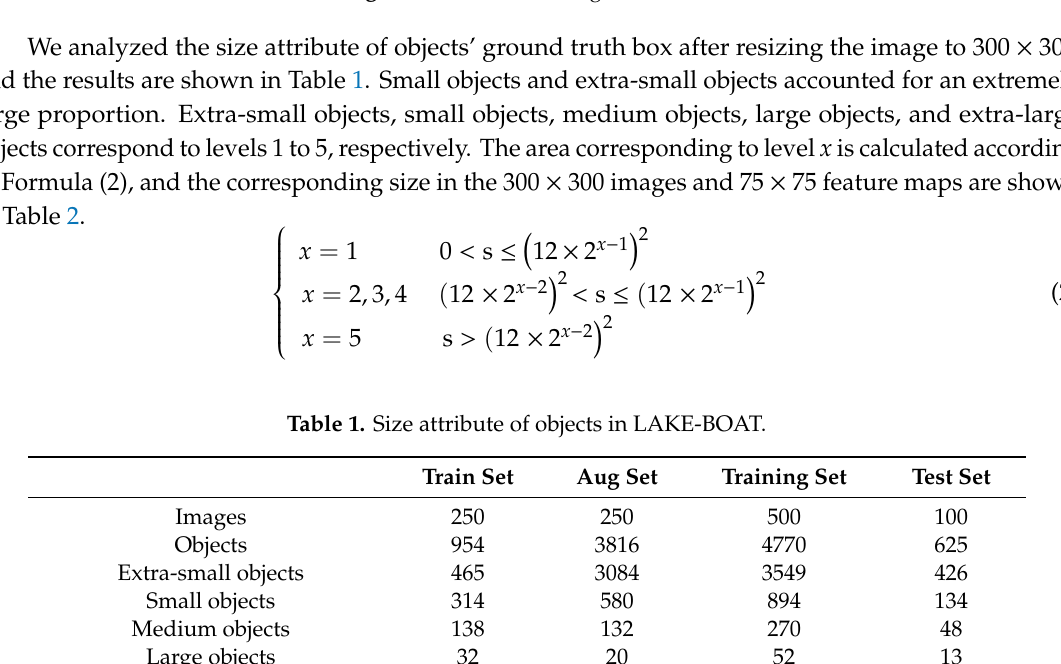
Figure 5. Offline data augmentation. Figure 5. O ffl ine data augmentation.